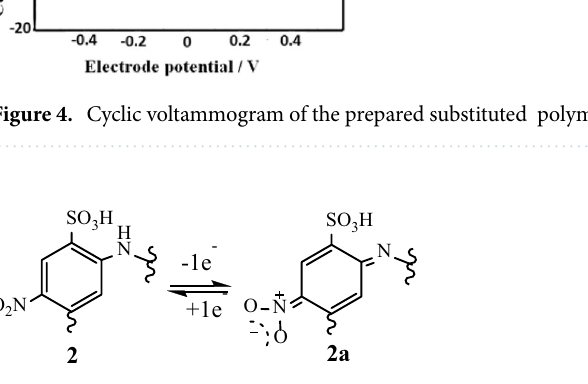
Figure 5. Reduced and resonating oxidized structures of the functionalized monomeric moiety in the copolymer